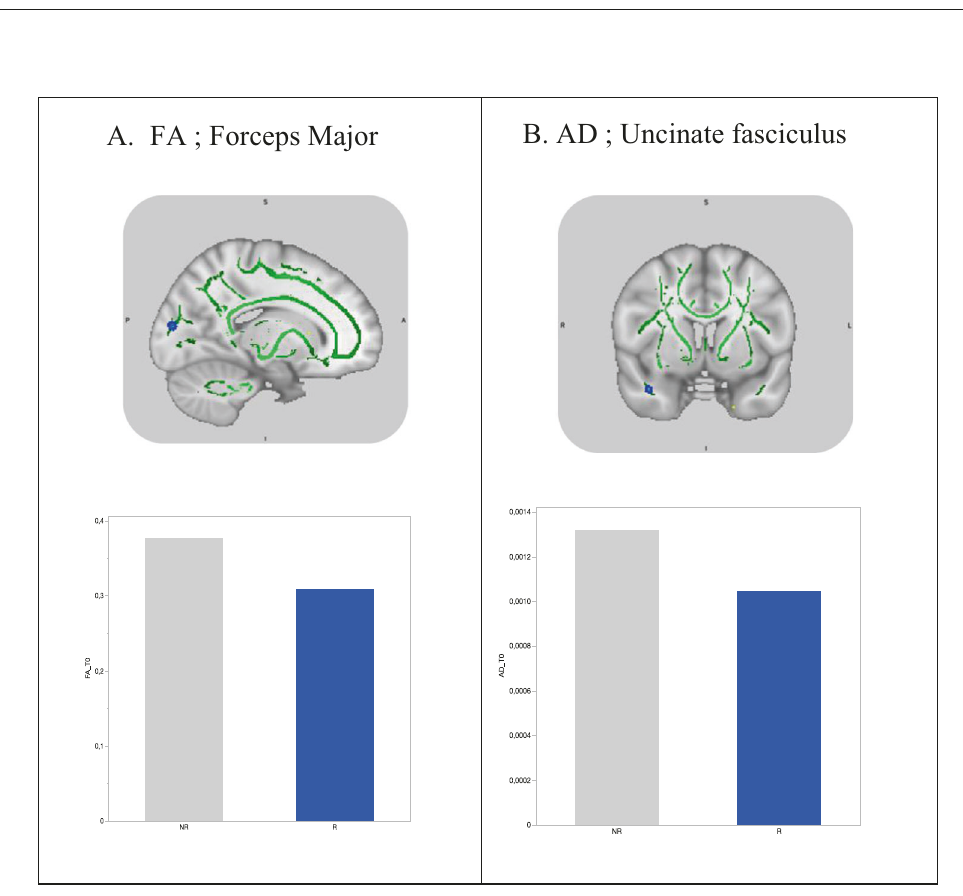
Fig. 1 Longitudinal changes of diffusivity metrics following ECT. An increase of FA was observed in the right splenium of the corpus callosum ( A.1 .) and the left cortico-spinal tract ( A.2 .). An increase in AD was observed in the left superior longitudinal fasciculus ( D.1 .) and in the right inferior fronto-occipital fasciculus ( D.2 .). MD did increase in the left superior longitudinal fasciculus ( B.1 .), the left cortico-spinal tract ( B.2 .) and the left inferior fronto-occipital fasciculus ( B.3 .). RD did increase in the right anterior thalamic radiation ( C.1 .), the left inferior longitudinal fasciculus ( C.2 .) and the right inferior fronto-occipital fasciculus ( C.3 .). The right forceps minor showed both an increase in MD and RD ( B.4., C.4 .). Abbreviations: FA = fractial anisotropy, MD = mean diffusivity, RD = radial diffusivity, AD = axial diffusivity, I = inferior, S = superior, R = right, L = left, A = anterior, P = posterior.